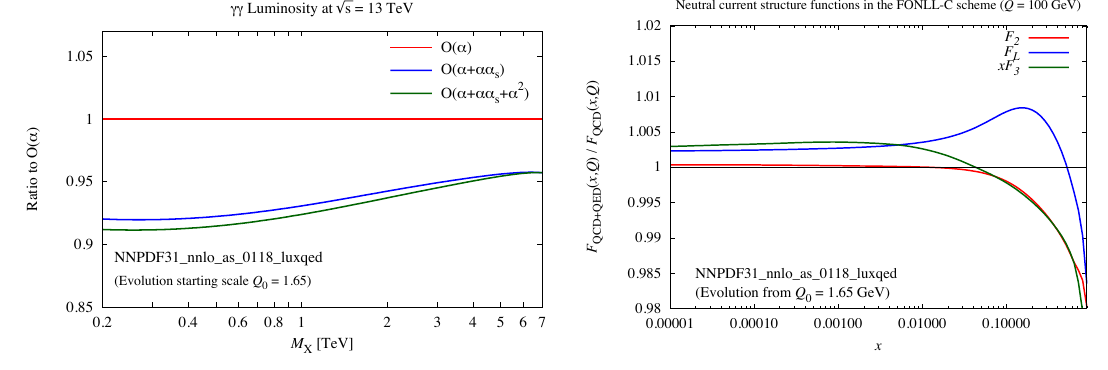
(cid:112) Figure 2.1: Left: comparison of the s = 13 TeV, computed starting from γγ luminosity at L = 1.65 GeV and then evolving upwards using different types of QED NNPDF3.1luxQED at Q 0 corrections in the DGLAP splitting functions. Right: comparison between the DIS splitting functions F , F , and xF at Q = 100 GeV with and without QED effects L 2 3